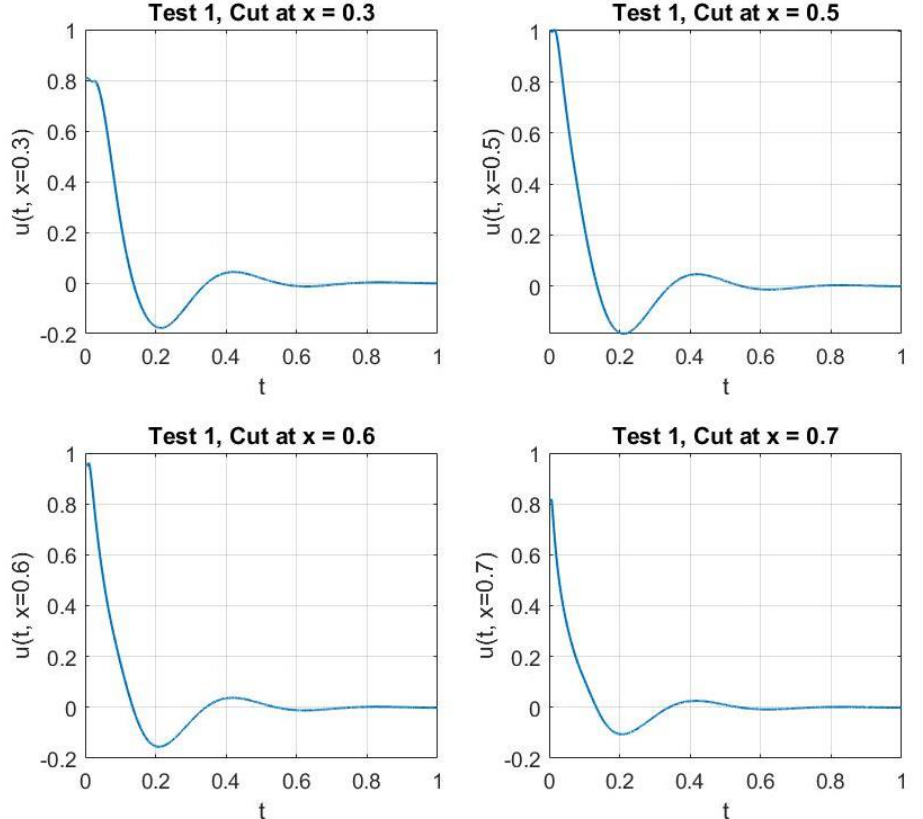
Figure 1. Test 1: The solution u ( t ) of the problem at fixed values of x .